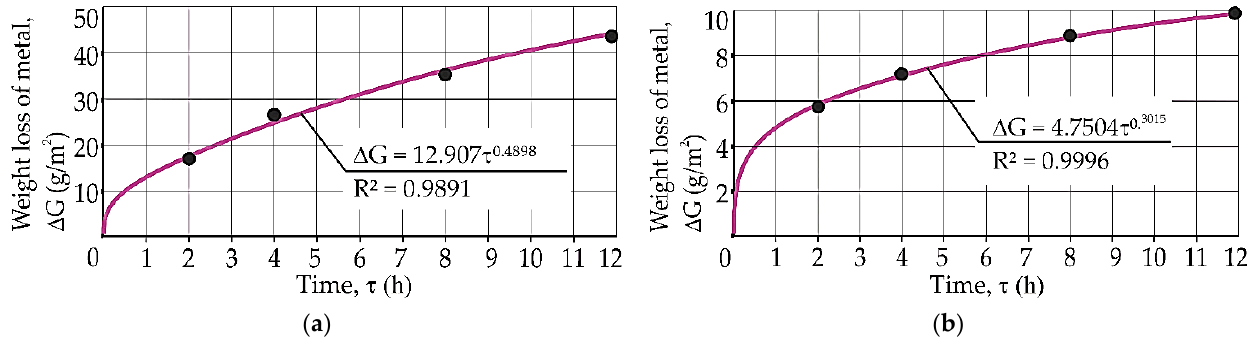
Figure 6. Dependences of the weight loss of metal ∆ G on time of experiments τ under fuel oil (S r = 1.5%, α = 2.9, W r = 2%) ( a ) and WFE (S r = 1.5%, α = 2.9, W r = 30%) ( b )